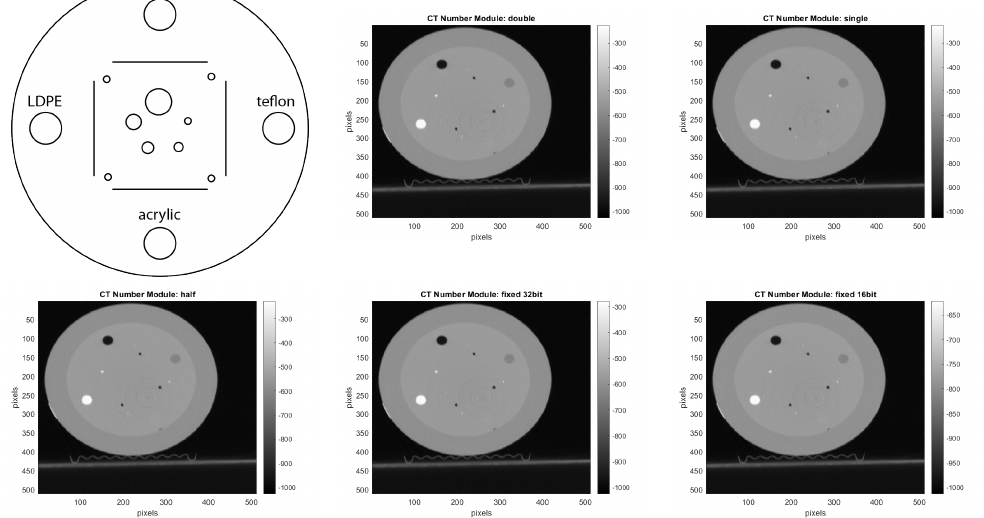
Figure 16. Reconstructed image of the CTP401 module for human visual